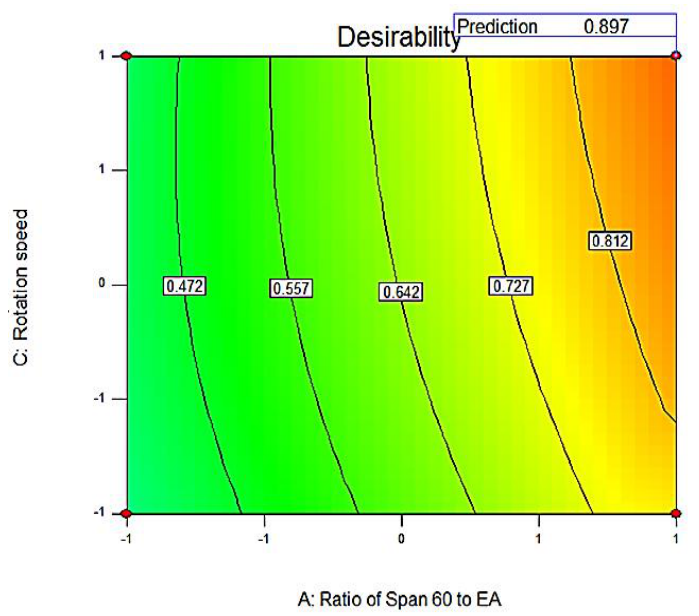
Figure 5. Contour plot showing the overall desirability of the optimized SV-loaded nanospanlastic formula (F8) as a function of independent variables. Abbreviations: SV, Sodium valproate.